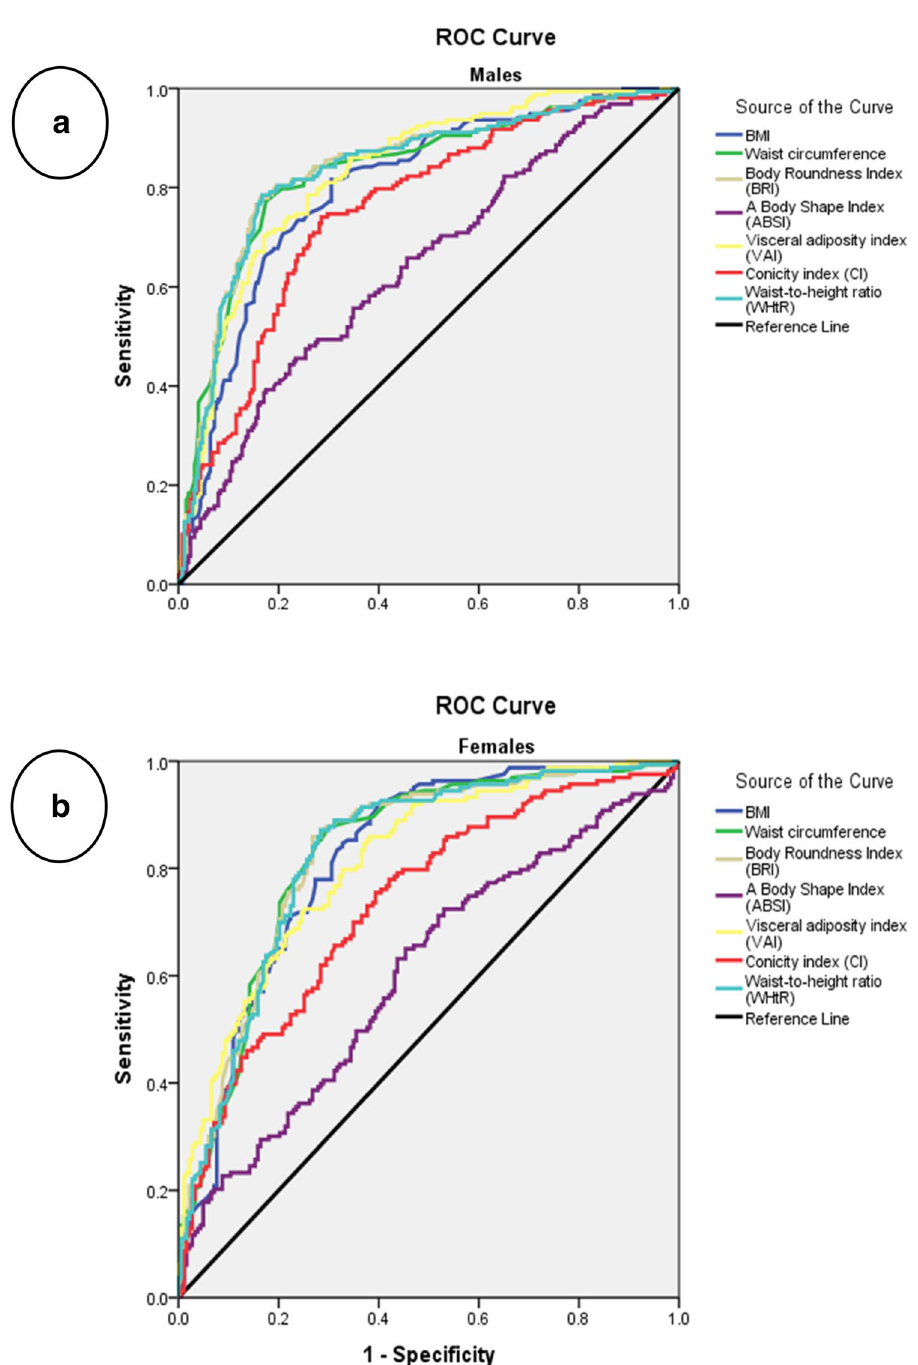
Figure 1. The receiver operating characteristic (ROC) curve of seven anthropometric indices describes their quality in predicting metabolic syndrome among male ( a ) and female ( b ) adults in